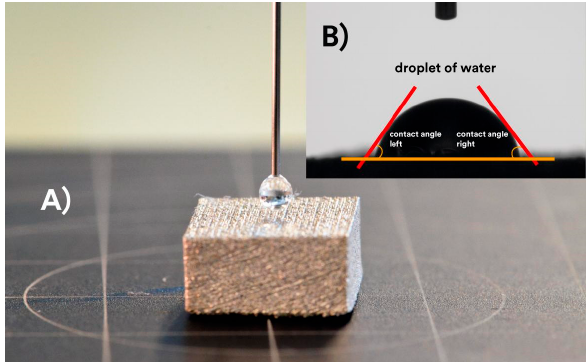
Figure 2. Contact angle configuration: ( A ) Stainless 316L surface and water drop; ( B ) Contact angle analysis.